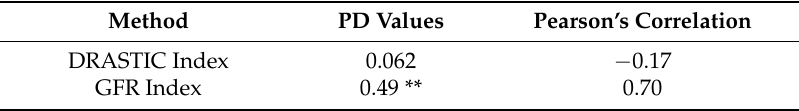
Table 8. PD values and Pearson’s correlation for DRASTIC and GFR